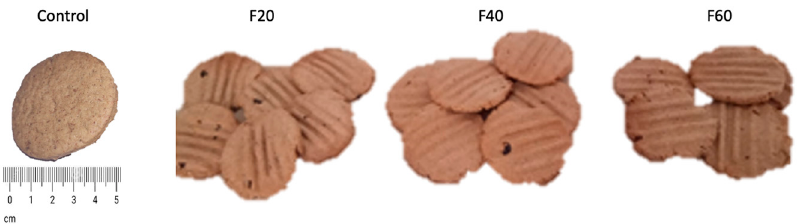
Figure 8. Maya nut cookies. Control (100% wheat flour cookies), F20 (20% naturally sun dried- flour), F40 (40% naturally sun-dried flour) and F60 (60% naturally sun-dried flour). Cookies are 5 cm diameter.